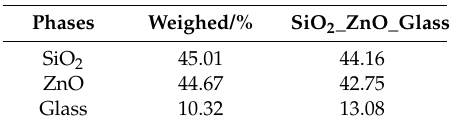
Table 5. Comparison of the Weight Fractions and Rietveld Quantitative Result (G-factor Method) of Artificial